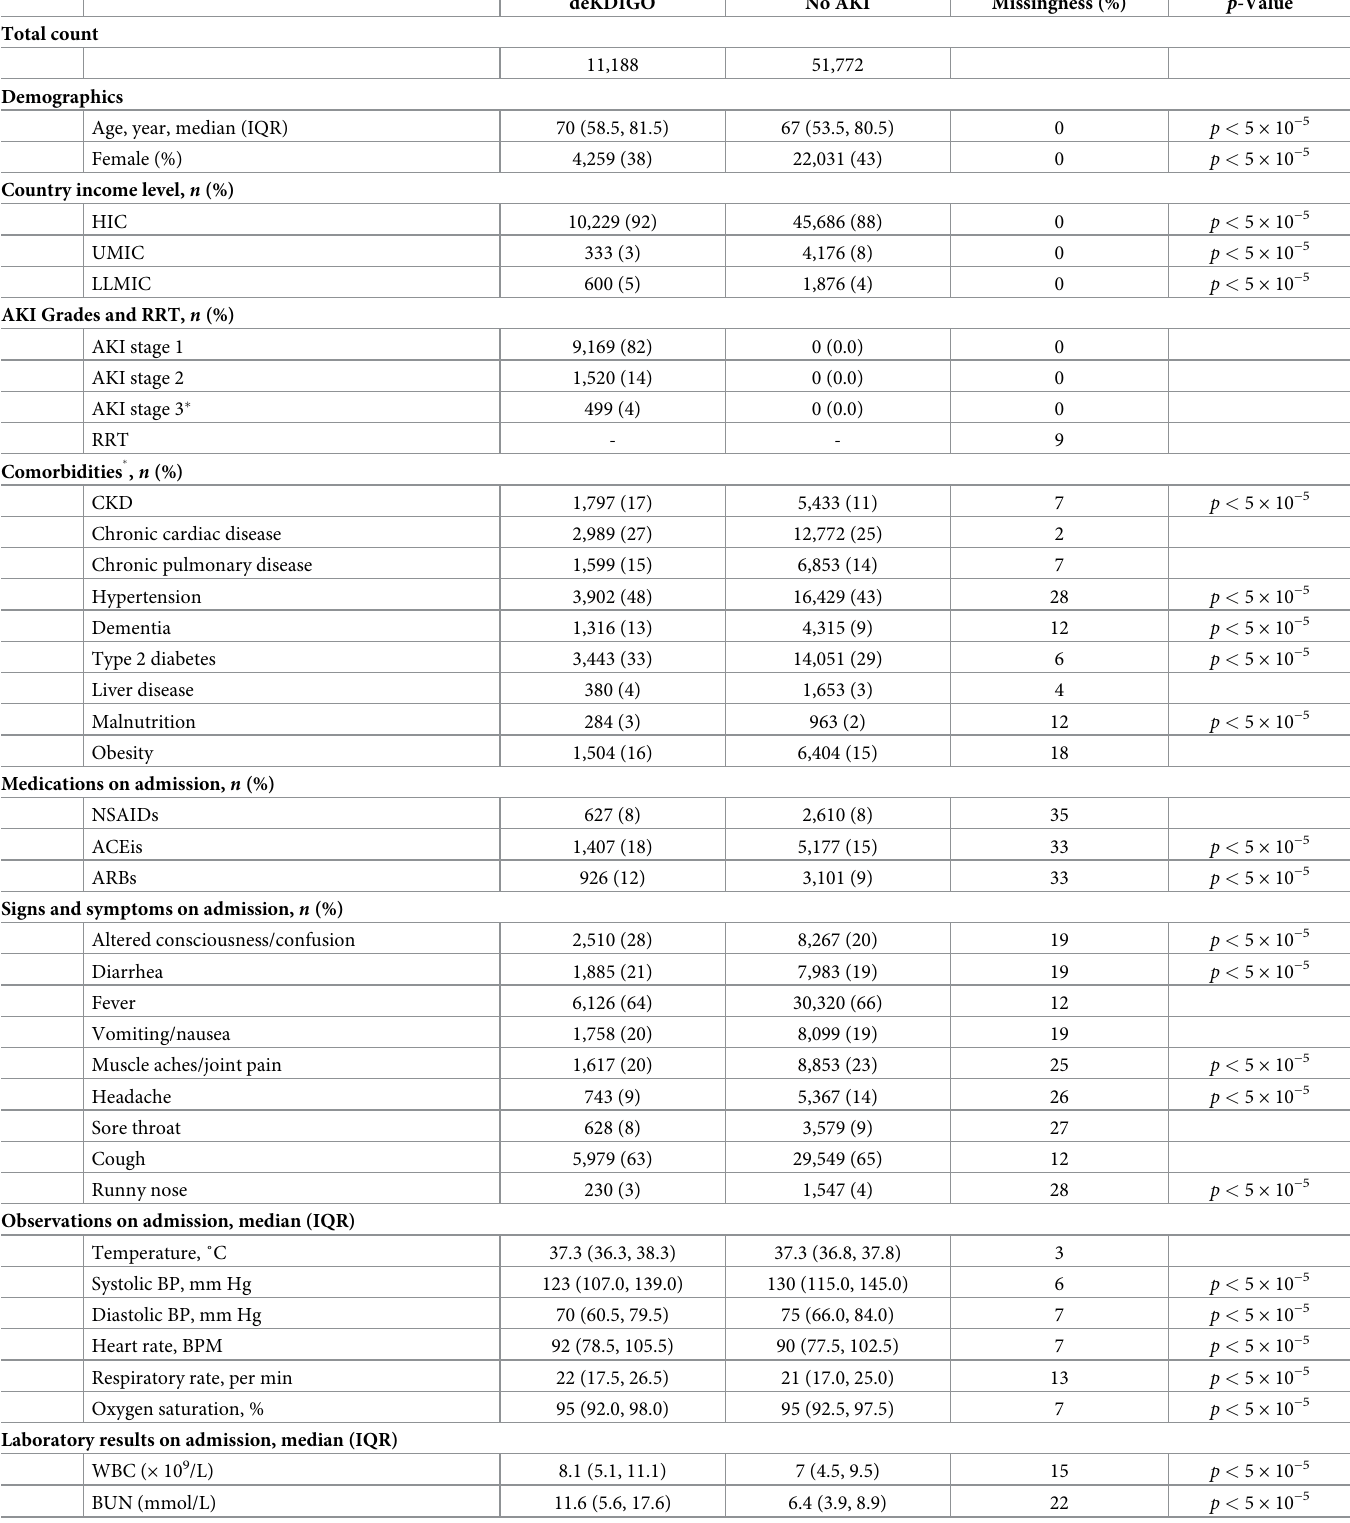
Table 4. Characteristics of patients with AKI diagnosed using eKDIGO only by the decrease in sCr (deKDIGO) and no AKI.